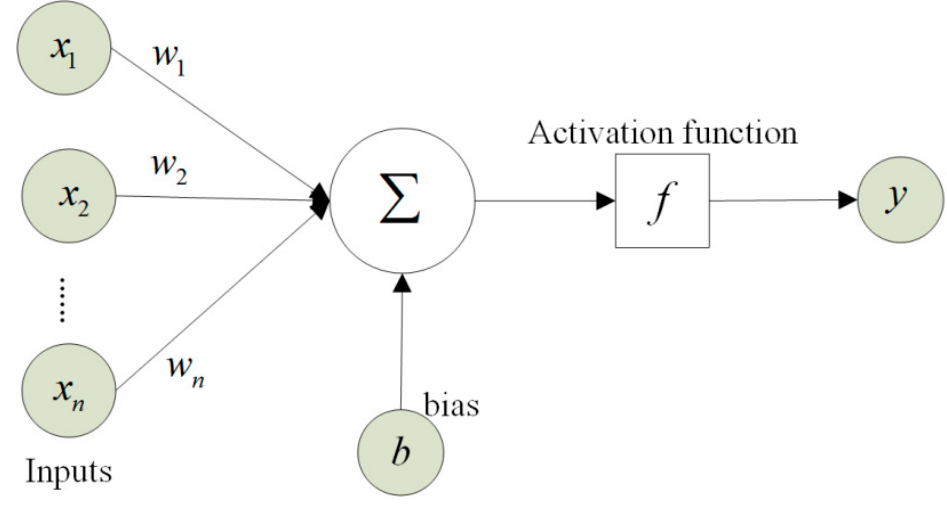
Figure 1. An illustration of a basic neuron.